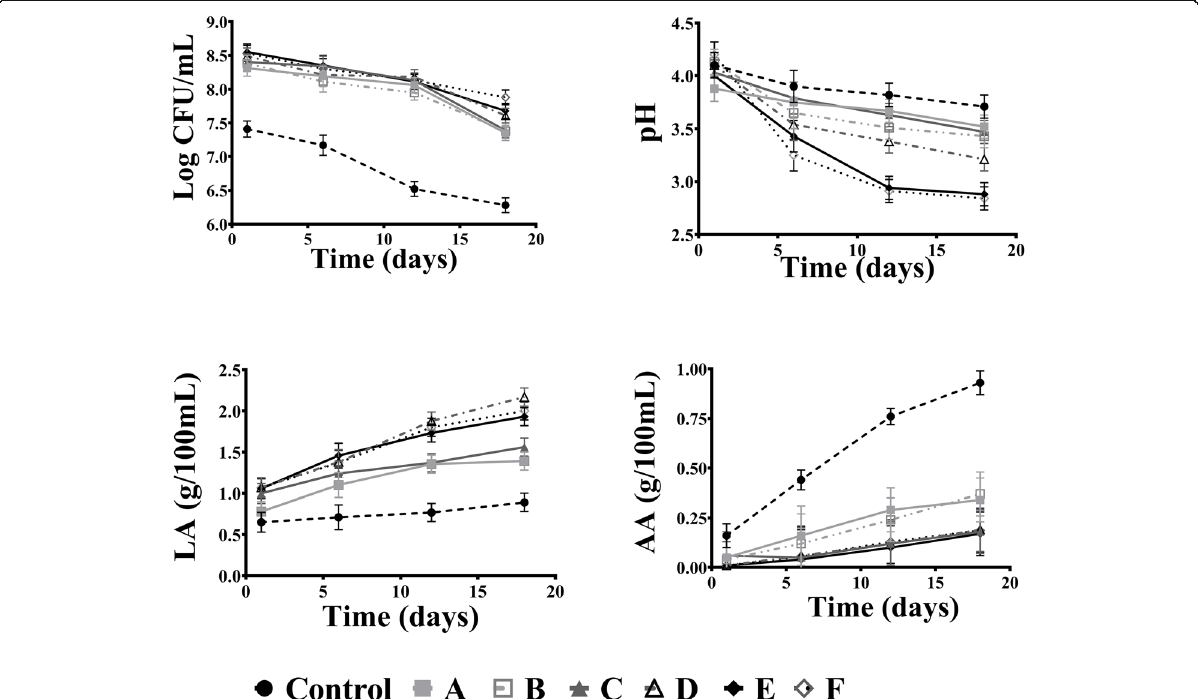
Fig. 5 Microbiological and physicochemical analysis of lacto-fermented cucumber during fermentation period. a Changes in viable cell number of LAB in different samples, b pH, c LA (Lactic acid), and d AA (Acetic acid) during fermentation. Control: without bacterial inocula with 4% (w/v) NaCl, pH 4; A: L. plantarum NPL 1258 with 4% (w/v) NaCl, pH 4; B: L. plantarum NPL 1258 with 4% (w/v) NaCl, 0.2% inulin, pH 4; C: P. pentosaceus NPL 1264 with 4% (w/v) NaCl, pH 4; D: P. pentosaceus NPL 1264 with 4% (w/v) NaCl, 0.2% inulin, pH 4; E: L. plantarum NPL 1258 and P. pentosaceus NPL 1264 with 4% (w/v) NaCl, pH 4; F: L. plantarum NPL 1258 and P. pentosaceus NPL 1264 with 4% (w/v) NaCl, 0.2% inulin, pH 4. Results are means of three independent experiments with three repetitions ± SD, n = 3